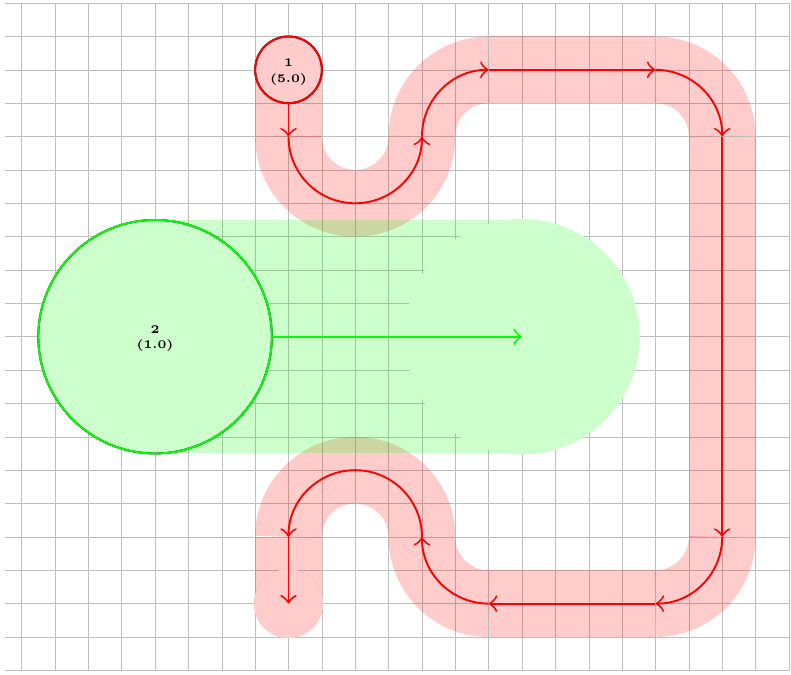
Figure 3. Counterexample instance for solution